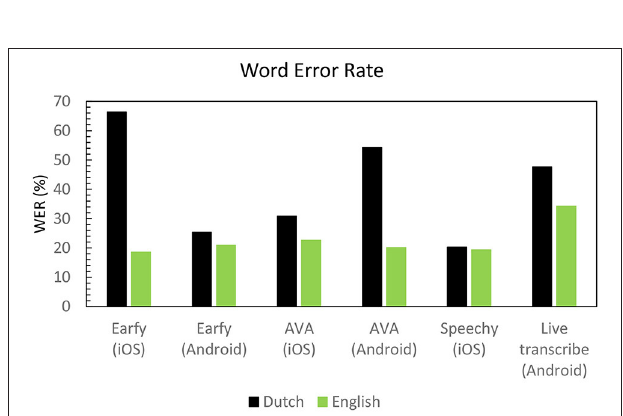
FIGURE 5 | Word error rate in percentage of the dialogue in English and Dutch for the different apps.